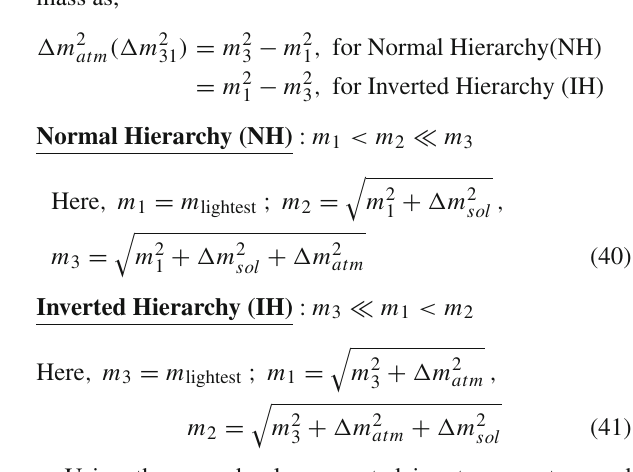
Table 5 The numerical values of the phase-space factor and nuclear matrix elements